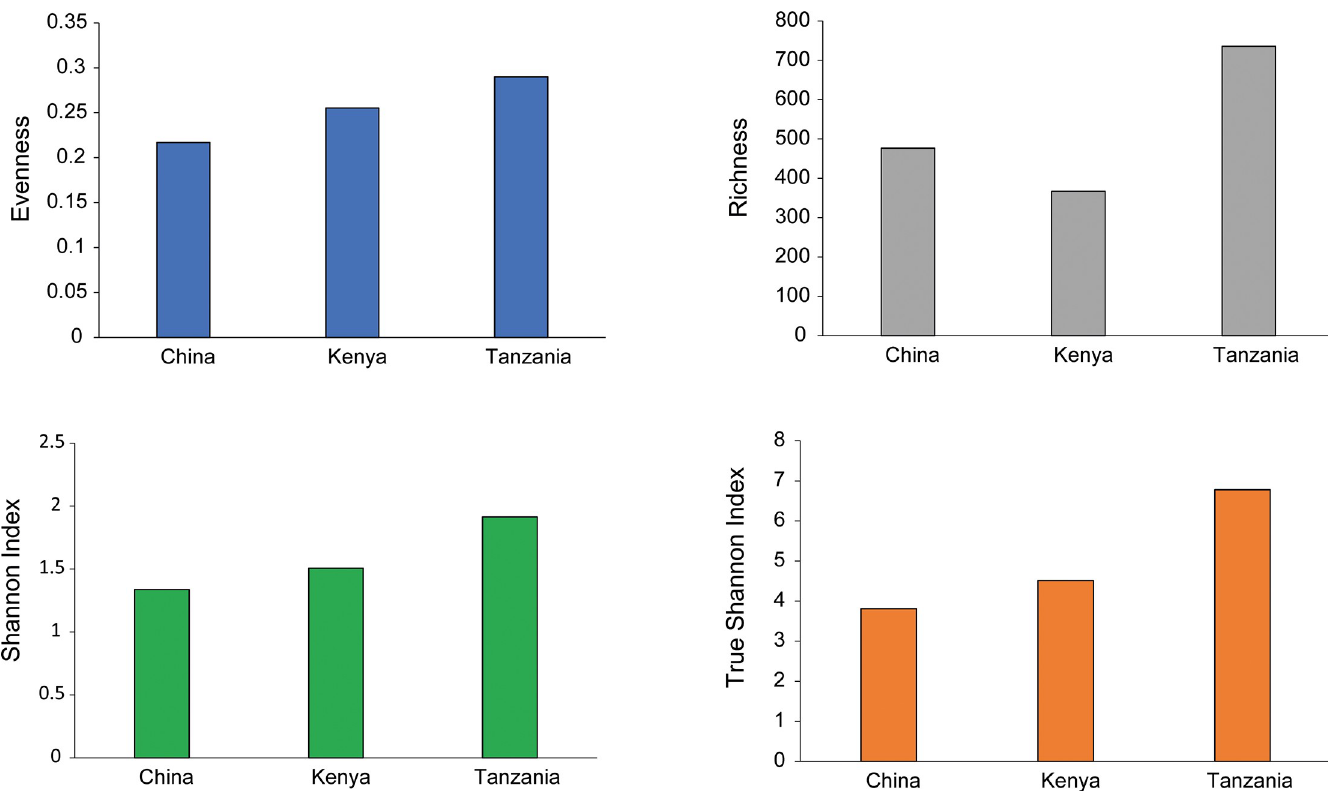
Fig 4. Alpha-diversity measures using evenness, Shannon diversity index, and species richness at the genus level across Diaphorina citri collected in different world regions (China, Kenya and Tanzania). The samples were composed by five pooled individual insects, and are represented on the X-axis, and their estimated diversity is represented on the Y-axis.